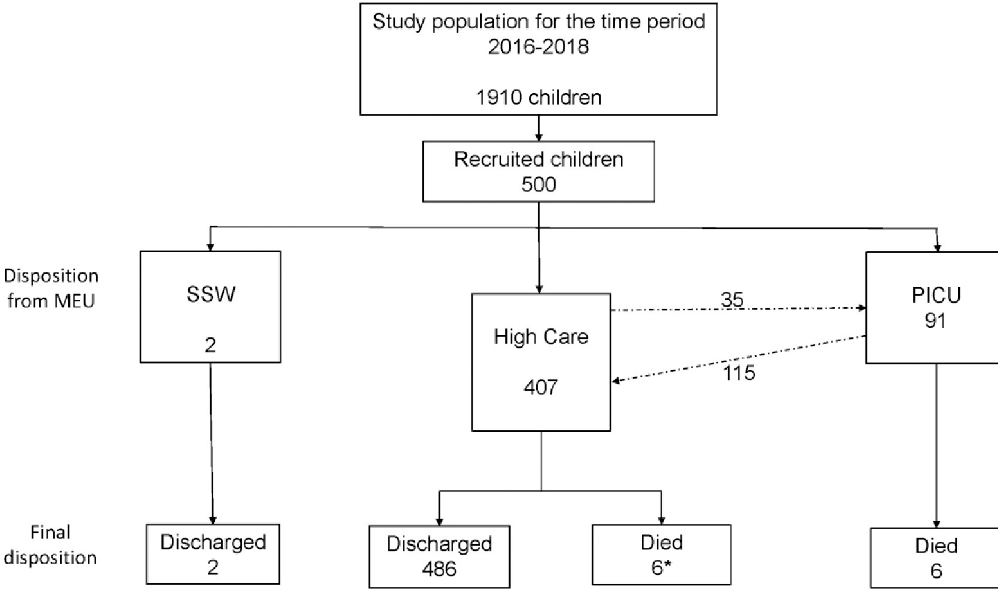
Fig 1. The study recruitment and outcome by initial disposal. � 5 included in the 35 transferred to PICU and died in PICU; MEU- medical emergency unit; SSW- short stay ward; PICU- paediatric intensive care unit.